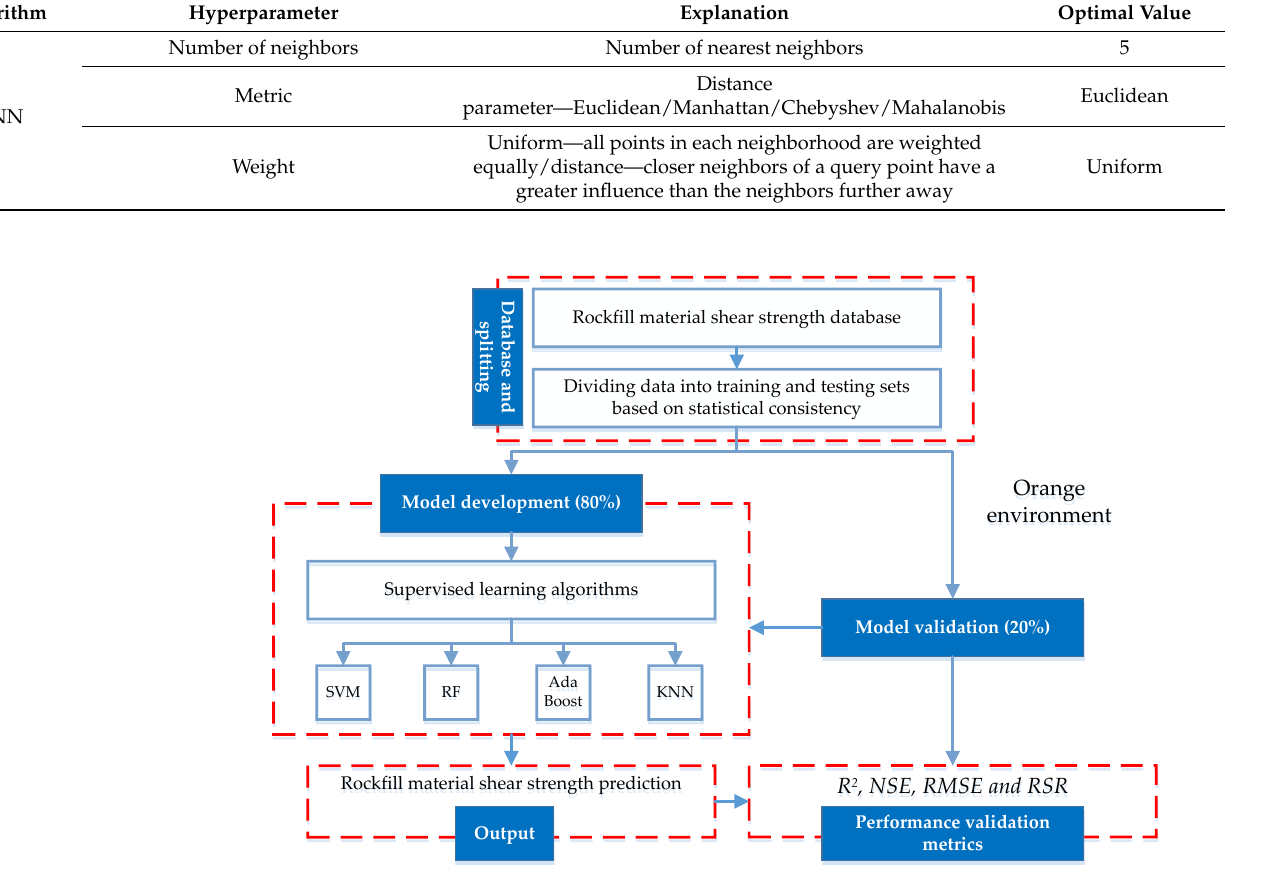
Figure 2. The flowchart of the methodology.